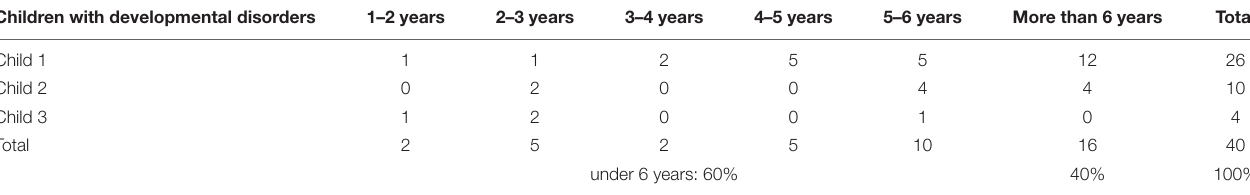
TABLE 1B | Ages of the 40 children diagnosed with a developmental disorder. Children with developmental